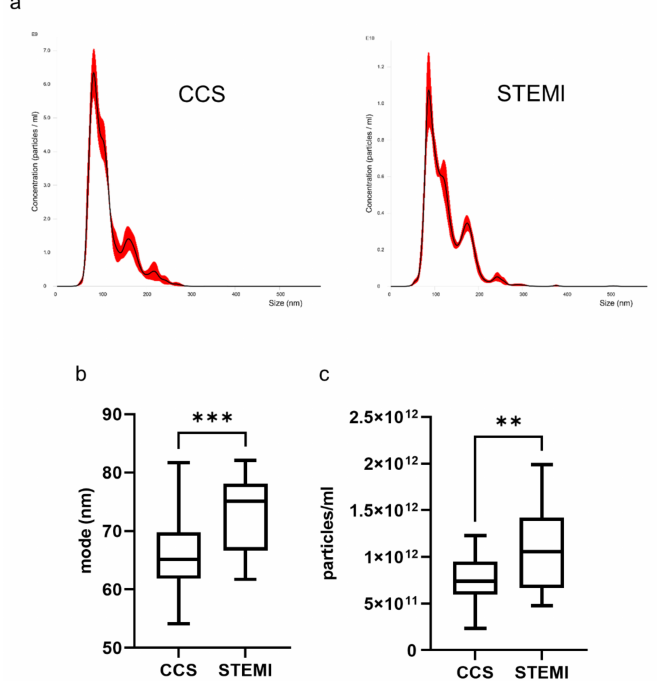
Figure 1. Exosome concentration and dimension are different between CCS and STEMI patients. Exosomes were isolated from plasma of CCS (N = 32) and STEMI (N = 18) patients and analyzed by NTA. ( a ) Representative NTA traces of exosomes isolated from plasma of CCS and STEMI patients. ( b , c ) Analysis of exosome dimension (mode) ( b ) and concentration (number of particles/mL) ( c ) as assessed by NTA. For each box plot, the center line illustrates the median and box limits indicate the 25th and 75th percentiles. ** p < 0.01, *** p <